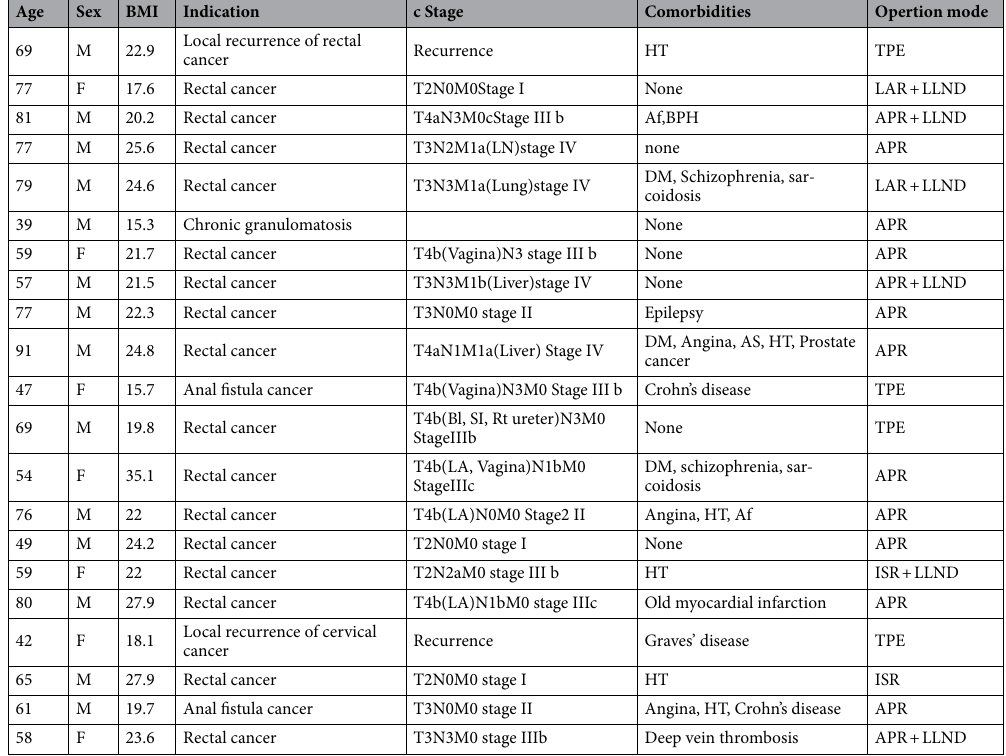
Table 2. Background patient characteristics. DM Diabetes mellitus; HT Hypertension; Af Atrial fibrillation; AS Aortic valve stenosis; BPH Benign prostatic hypertrophy; LA levator ani muscle; Bl : Bladder; SI small intestine; LN lymph node; LLND Latelal lymph node dissection.